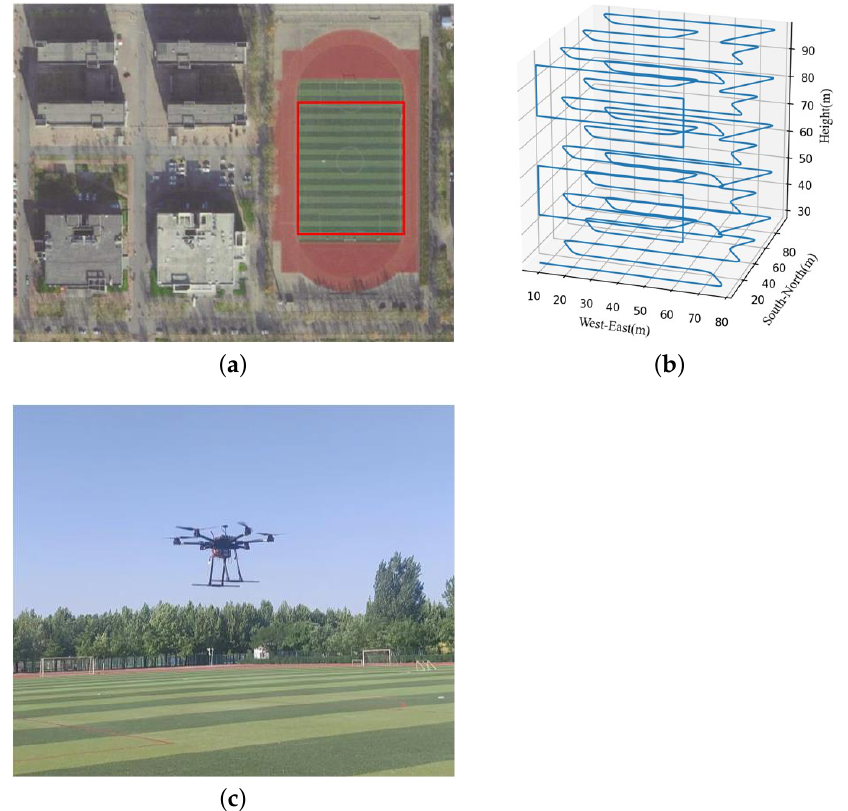
Figure 8. ( a ) Field tests. The red area is the detection area. ( b ) 3D detection path. ( c ) UAV in field tests. A total of 14 gas data are obtained for the experiment: 2 per day. Each measurement lasts about 20 min, and the measured air pollution components are CO, PM2.5 and PM10.